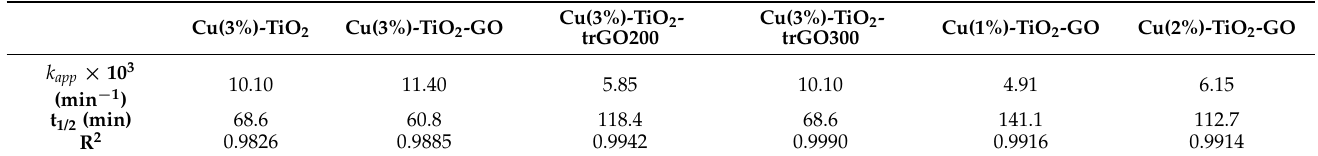
Table 3. ThekineticparameterscorrespondingtothemostefficientphotocatalystsforMB